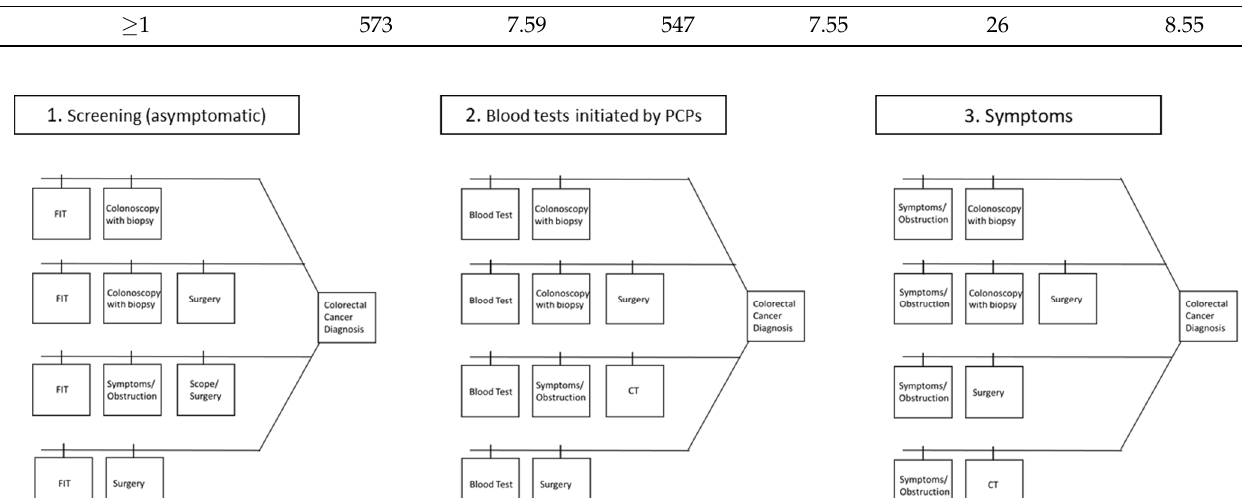
Figure 3. Median diagnostic intervals in days and interquartile range (IQR) by pathway among 7241 patients diagnosed with colorectal cancer between 1 January 2016 and 1 March 2020. PCP = Primary care physicians. 3.1.2. Comparison of Diagnostic Pathways and Intervals Pre- and Intra-COVID-19 There were 398 patients diagnosed with CRC intra-pandemic. Of these, 76.4% were classified into the identified diagnostic pathways. Pre-pandemic, the proportion of pa- tients diagnosed through pathways initiated by screening, blood tests in primary care, or urgent care were 31·2%, 47·4%, and 20·5%, respectively. The proportion of patients diag- nosed through the screening pathways was reduced by 6.5% during the pandemic (15.9% of patients diagnosed after March 2020). The proportion of patients diagnosed through pathways initiated by blood tests in primary care remained approximately the same pre- and intra-COVID-19 (pre-COVID-19, 47.4%; intra-COVID-19, 46.1%). Lastly, the propor- tion of patients diagnosed with symptomatic disease in urgent care increased by 2.7% during the pandemic, relative to before (38.2% of patients diagnosed after March 2020). The median number of days between each diagnostic milestone for all the pathways among patients diagnosed before the pandemic and during the pandemic are shown in Table 3.